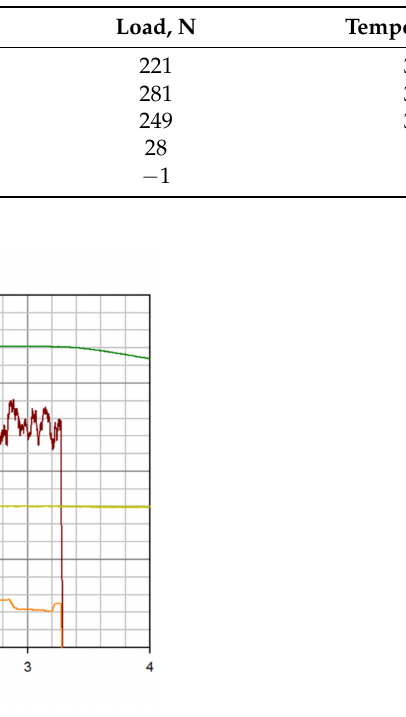
Table 3. Measured stability values of load and temperature. Target load was 250 N and target temperature 340 ◦ C.